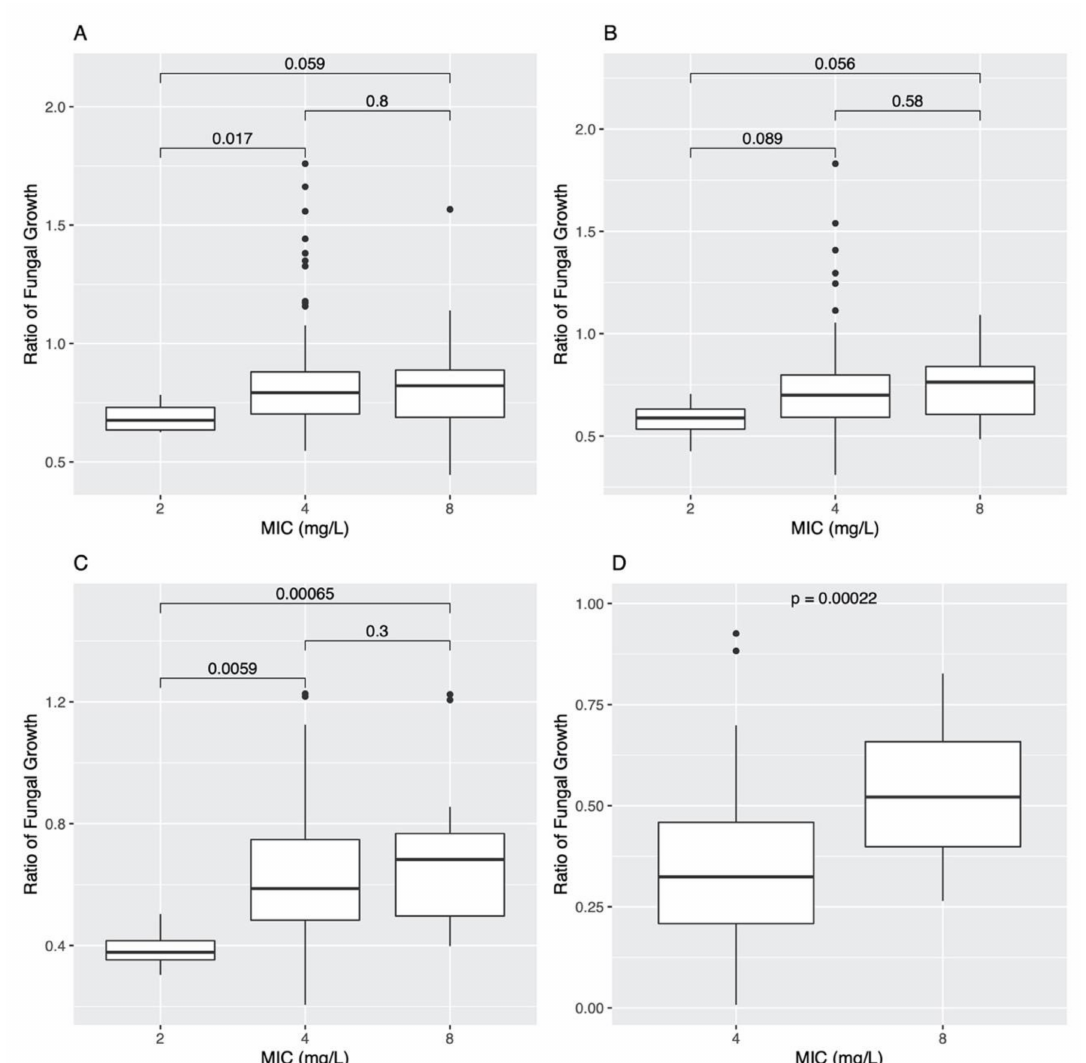
Figure 3. Ratio of fungal growth for the 143 progeny strains in Amphotericin B concentrations of ( A ) 0.25 mg/L, ( B ) 0.50 mg/L, ( C ) 1.00 mg/L, and ( D ) 2.00 mg/L. Fungal growth was determined by calculating difference in OD 530 at start (0 h) and end of incubation (48 h); this value was divided by fungal growth in the positive control to determine ratio of fungal growth. Welch’s t -test p -values are also denoted to compare the AMB MIC groups of 2 mg/L ( n = 4), 4 mg/L ( n = 120), and 8 mg/L ( n = 19). Differences were considered statistically significant at p <